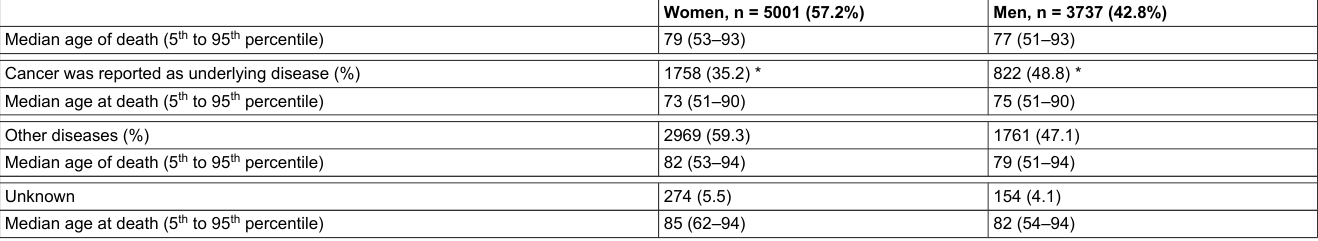
Table 4: Assisted suicide (AS) cases in Switzerland (1999–2018): distribution of sexes.